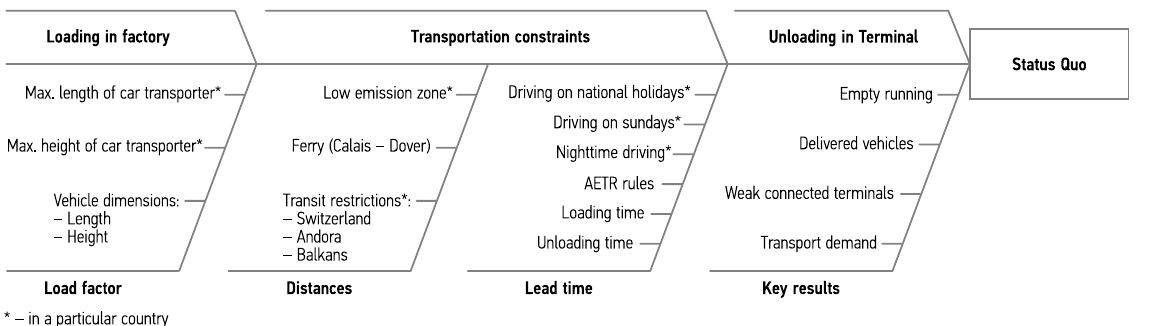
Fig. 2. Outbound scheme with particular limitations and the key results of the road transport scenario